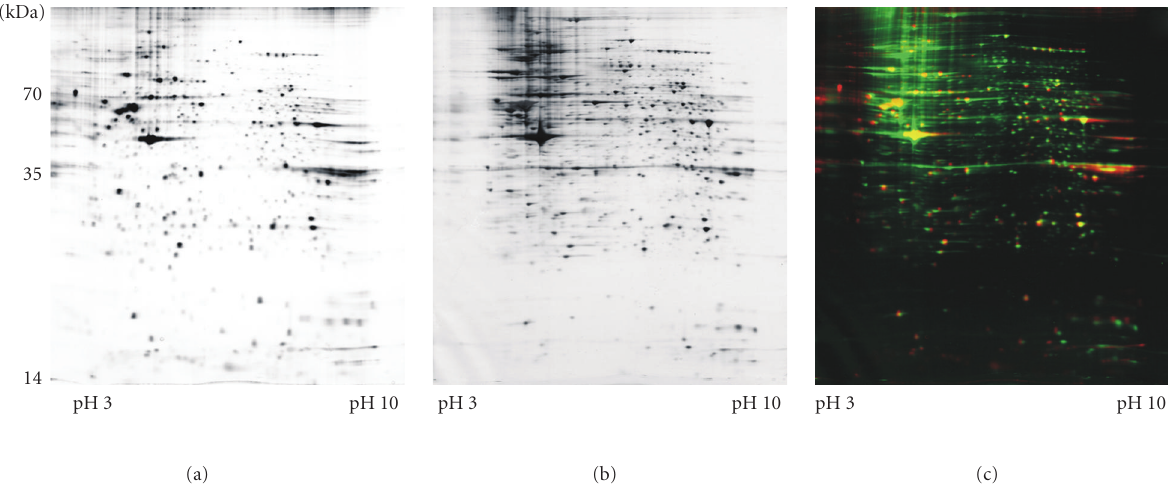
Figure 3: Comparison of 2DE gels of BM-MSCs and UCB-MSCs. This figure shows representative 2D gel images of (a) bone marrow (BM-)MSC proteins and (b) umbilical cord blood (UCB-)MSC proteins. (c) The false-colored overlay image of the two 2D gels shows the BM-MSC proteins colored in red, and the UCB-MSC proteins colored in green. The resulting overlaid color is yellow (data from [30, 47]). The overlaid gel images show a close relationship between the two cellular proteomes, but there seem to be more proteins in the BM-MSC group as well as some di ff erences in protein expression, as seen in the unique color in one of the